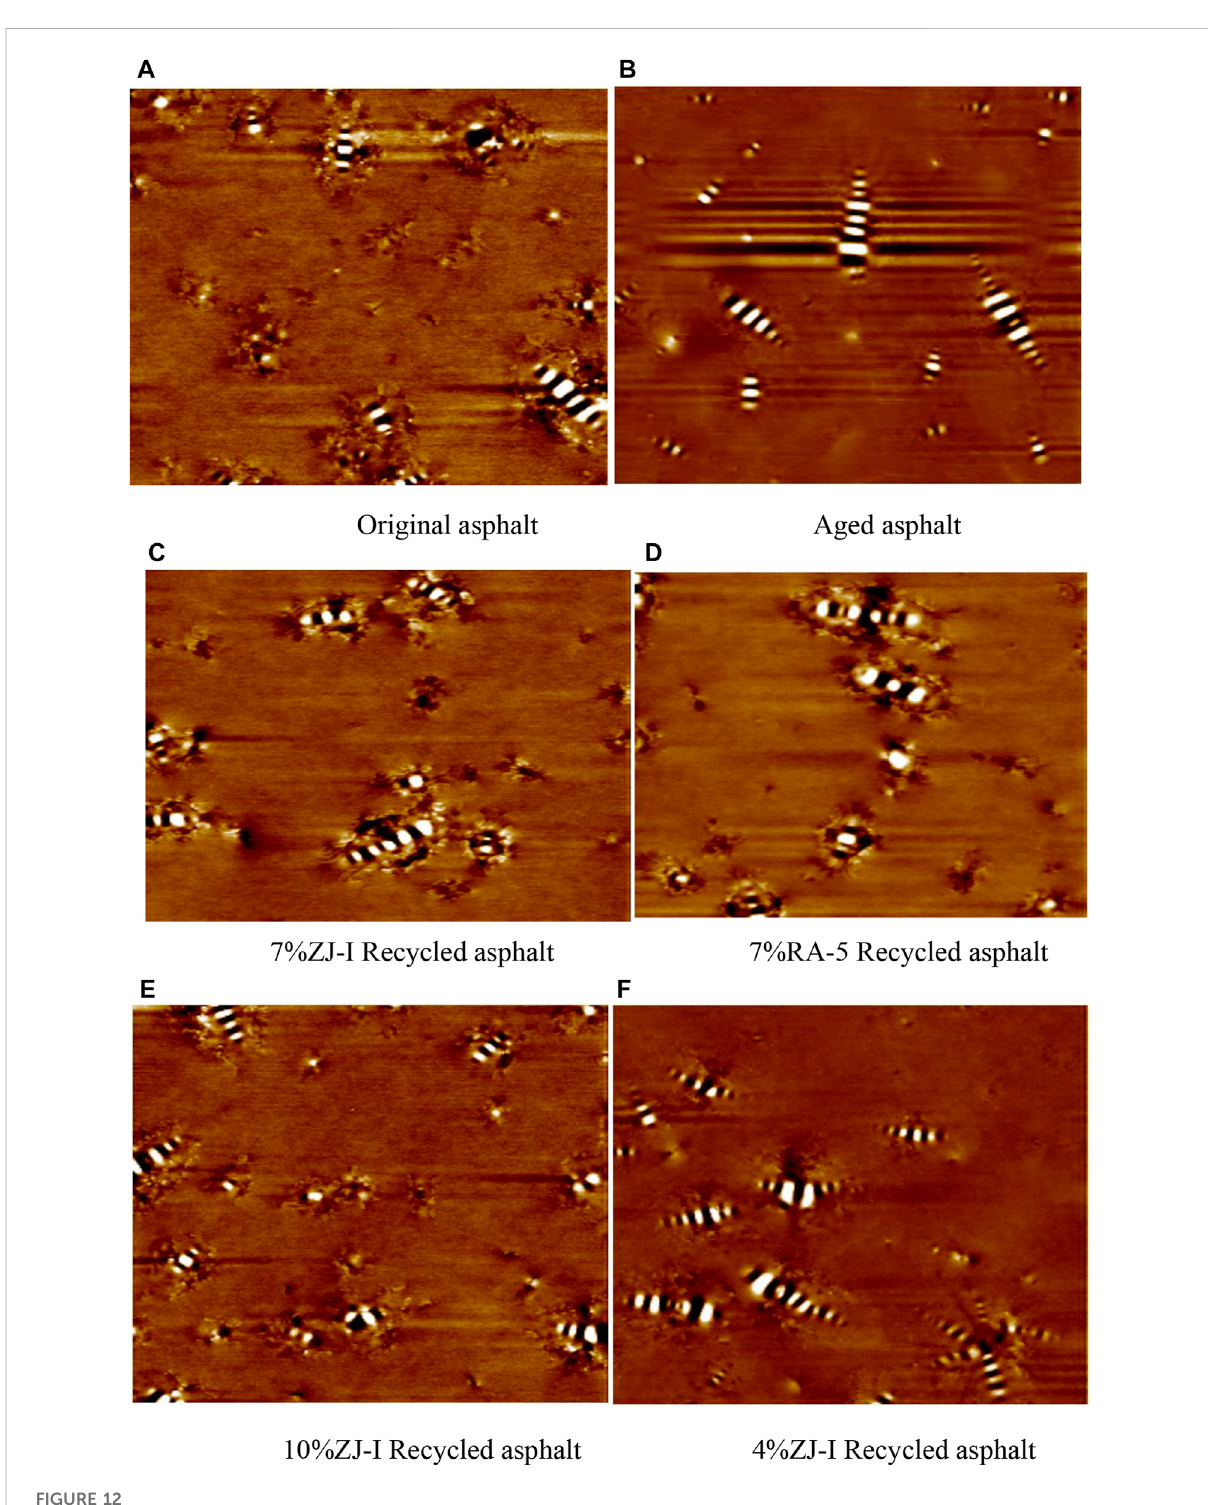
FIGURE 12 Two-dimensional AFM diagram of various